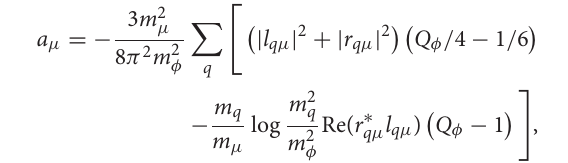
l − β l − γ l + δ (center and right) with X and X ′ scalar or vector mediators and f and f ′